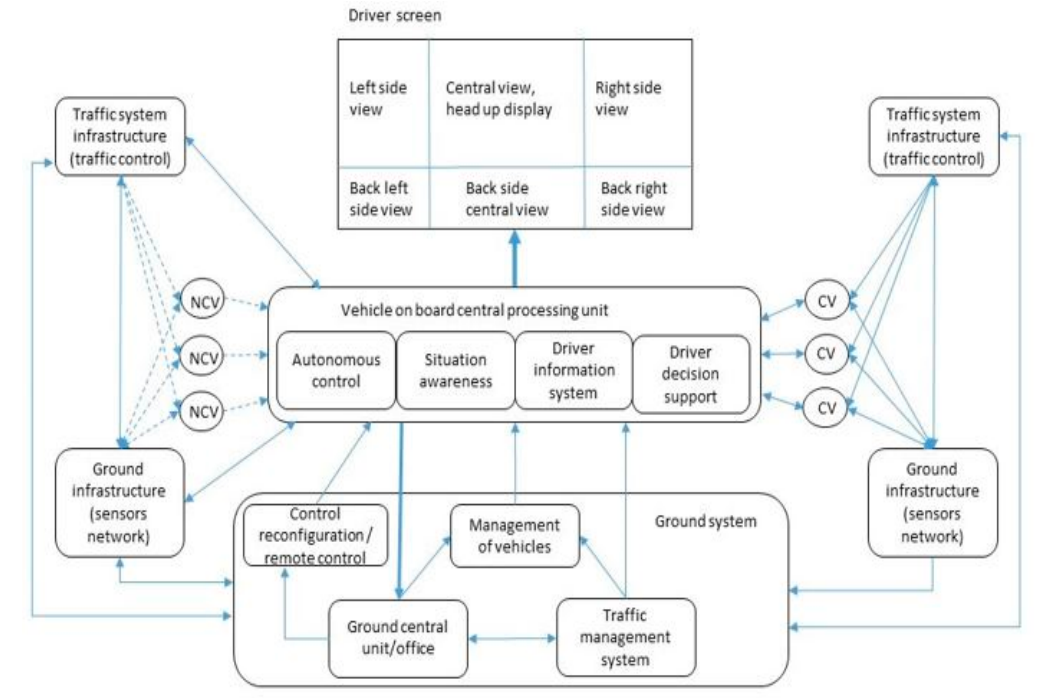
Figure 10. The traffic management system architecture (NCV—non-cooperating vehicle, CV— cooperating